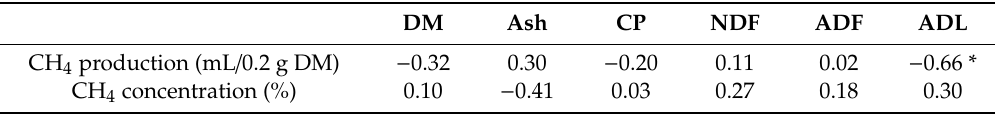
Table 5. Correlations coe ffi cients between CH 4 production, CH 4 concentration and forages chemical composition ( n =